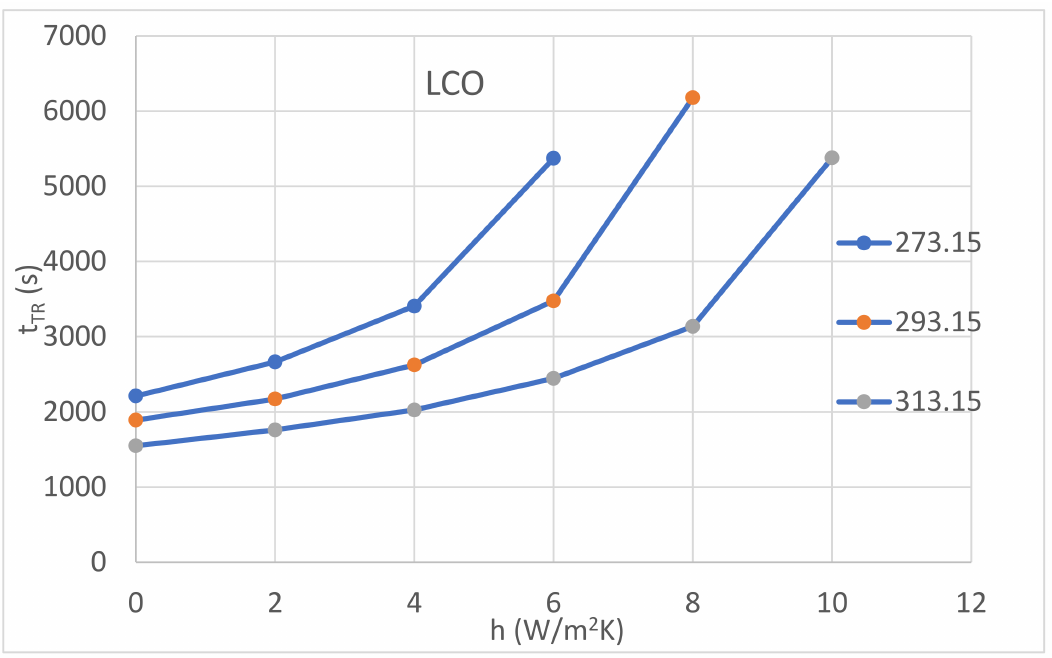
Figure 15. Thermal runaway ignition time for different ambient temperatures and heat exchange conditions (LCO cathode).